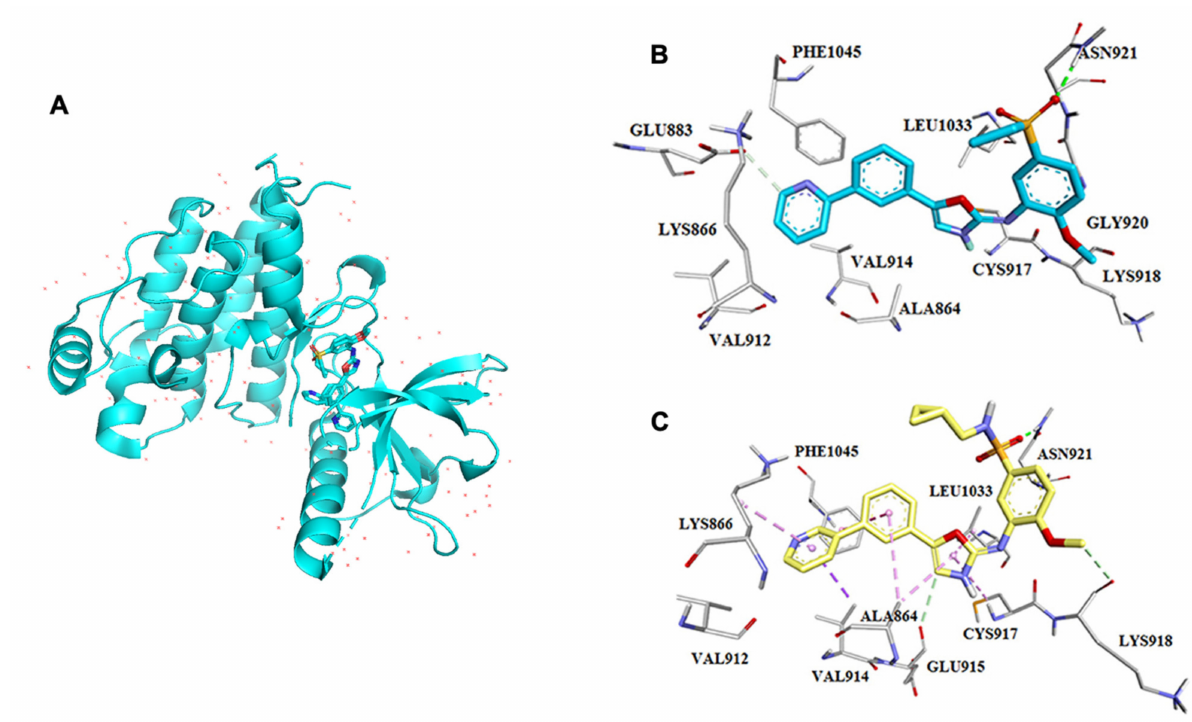
Figure 7. VEGF structure and interaction with its inhibitor pazopanib. ( A ) Structure of VEGF, ( B ) PDB: 1Y6A, ( C ) PDB: 1Y6B. These docked images were taken from Harris et al., 2005 [54] and 2008 [55].